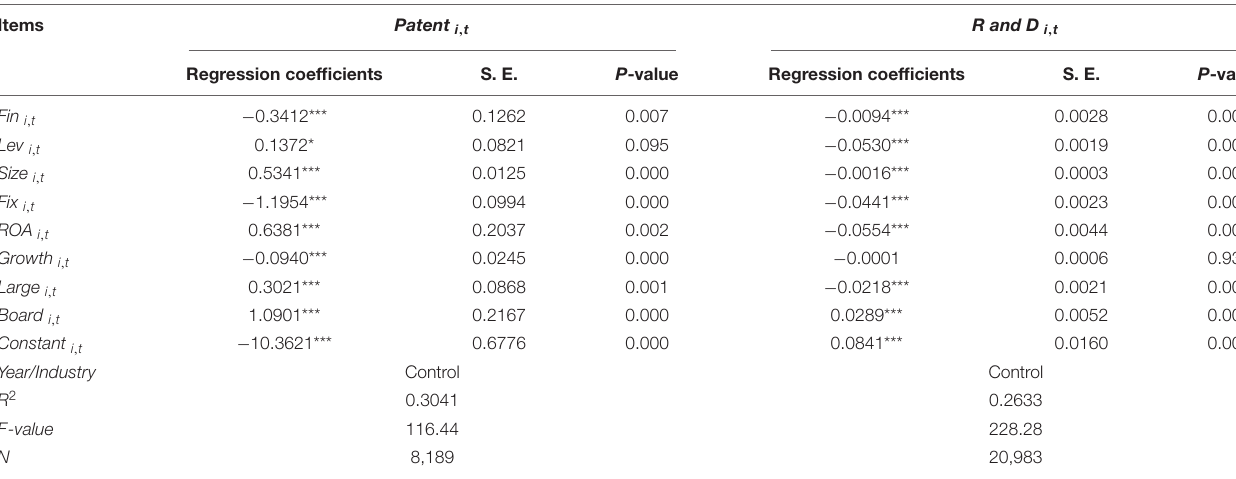
TABLE 6 | Select alternative key